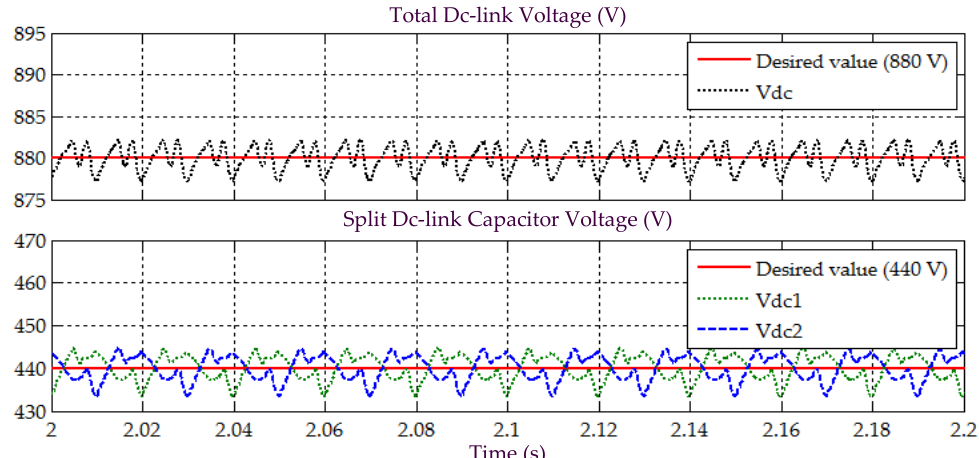
Figure 12. Simulation result obtained under Scenario B for Load 1, showing the total dc-link voltage V dc , and voltages across split dc-link capacitors V dc 1 and V dc 2 , demonstrated by SAPF while applying the proposed STF- dq 0 technique.